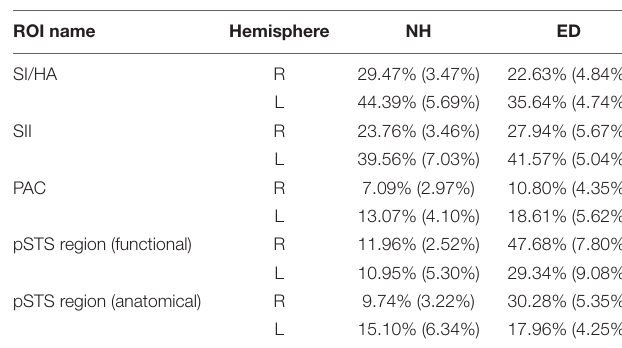
TABLE 3 | Percentage of voxels with significant tactile motion response in ROIs anatomically defined (SI/HA, SII, PAC, and pSTS) and functionally defined pSTS